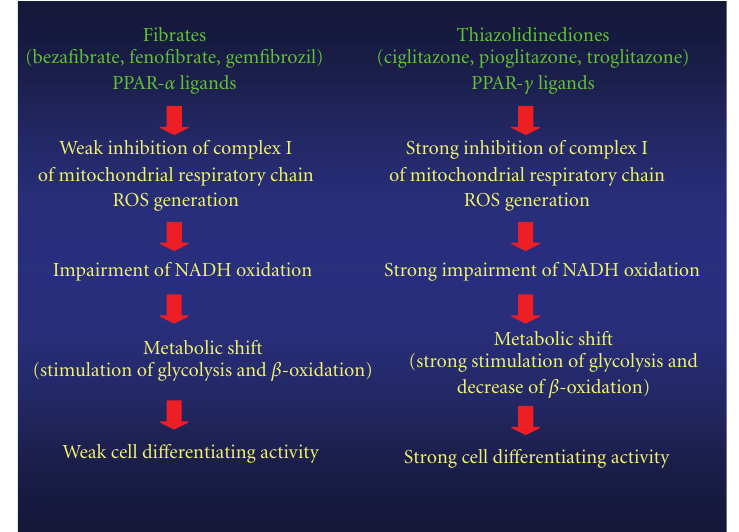
Figure 2: Flow chart of possible molecular mechanisms caused by a mitochondrial dysfunction induced by fibrates (PPAR- α ligands) and thiazolidinediones (PPAR- γ